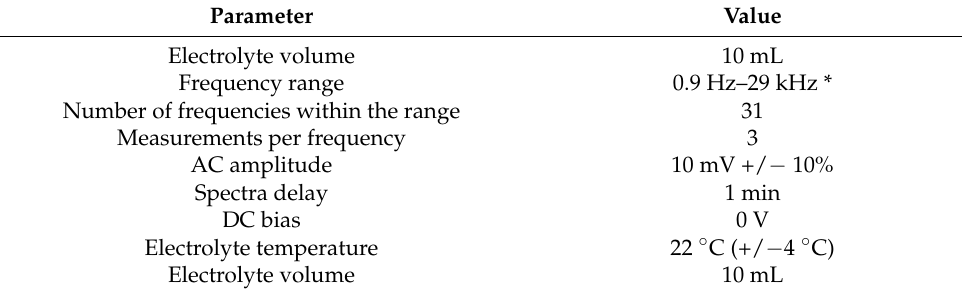
Table 1. EIS measurement parameters.